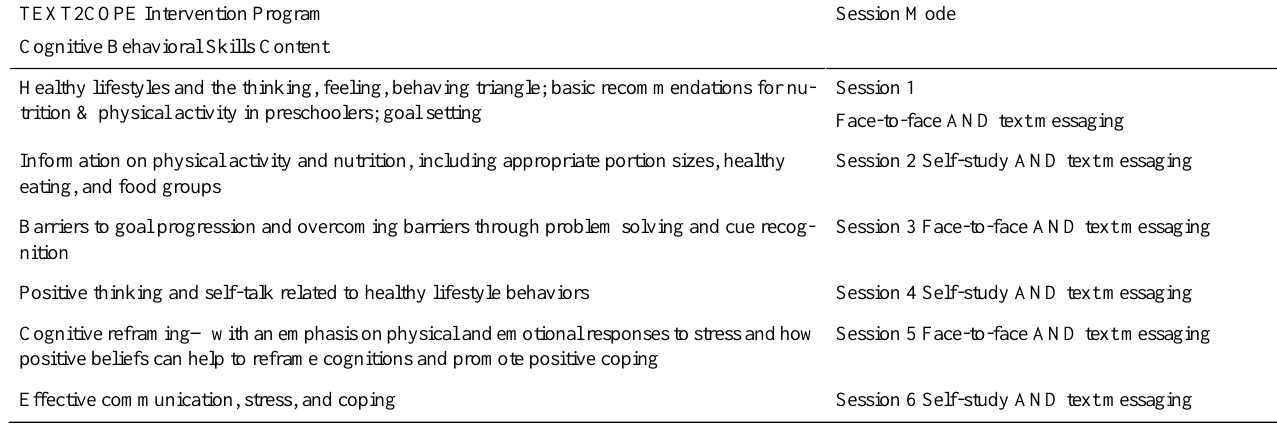
positive beliefs can help to reframe cognitions and promote positive